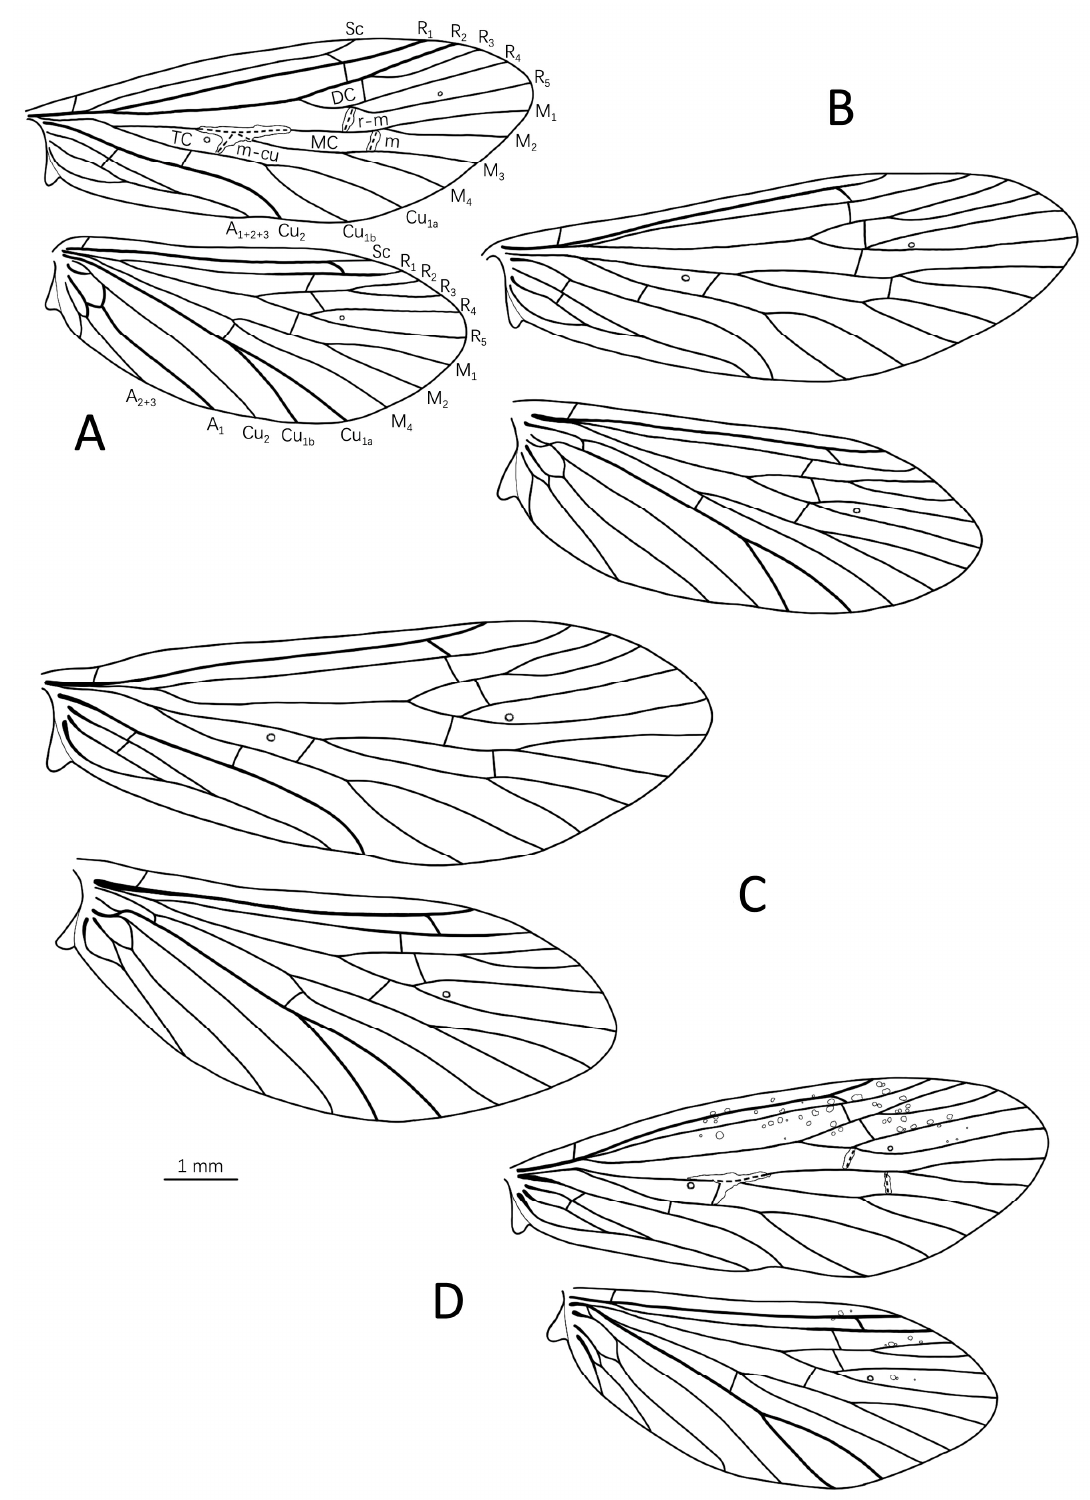
Figure 7. Wing venations of Eoneureclipsis species: ( A ) Eoneureclipsis jianfenglingensis sp. nov.; ( B ) E. foraminulatus sp. nov.; ( C ) E. spinosus sp. nov.; ( D ) E. gei sp. nov. Abbreviations: Sc = subcosta; R = radius; M = media; Cu = cunitus; A = anal; DC = discoidal cell; MC = medial cell; TC = thyridial cell. Scale bar refers to A–D. 310 3.2. Key to male Chinese Eoneureclipsis Species 311